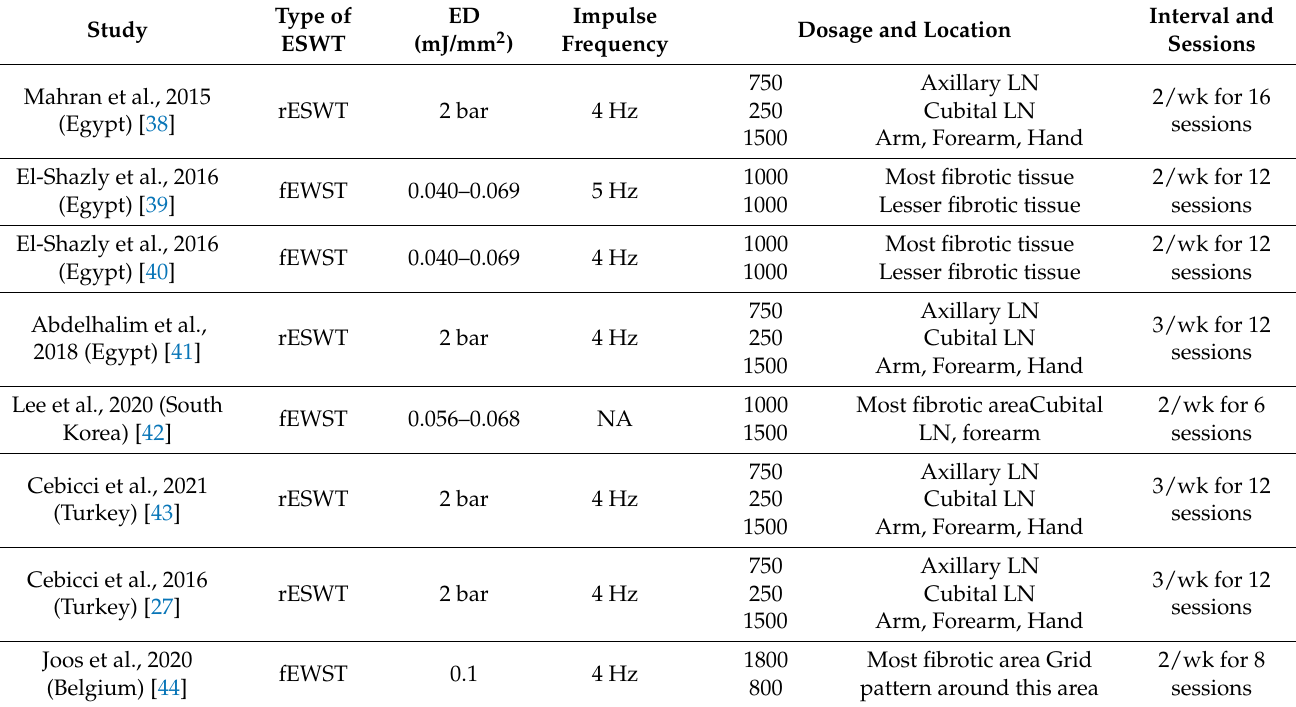
Table 3. Therapeutic protocols of included